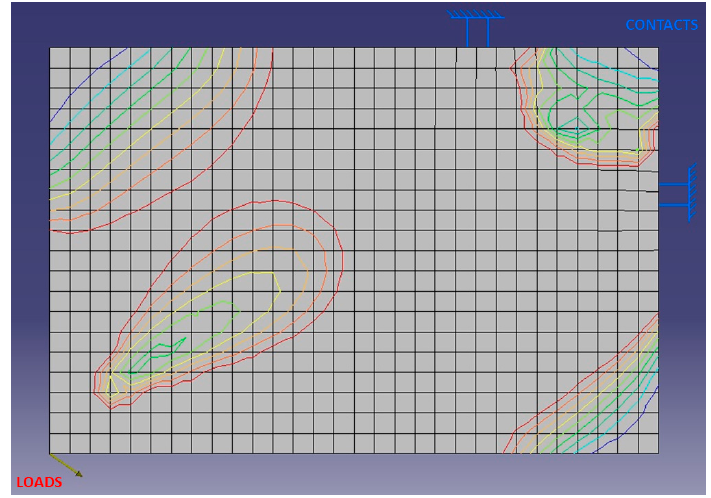
Figure 12. Part meshing and load case.